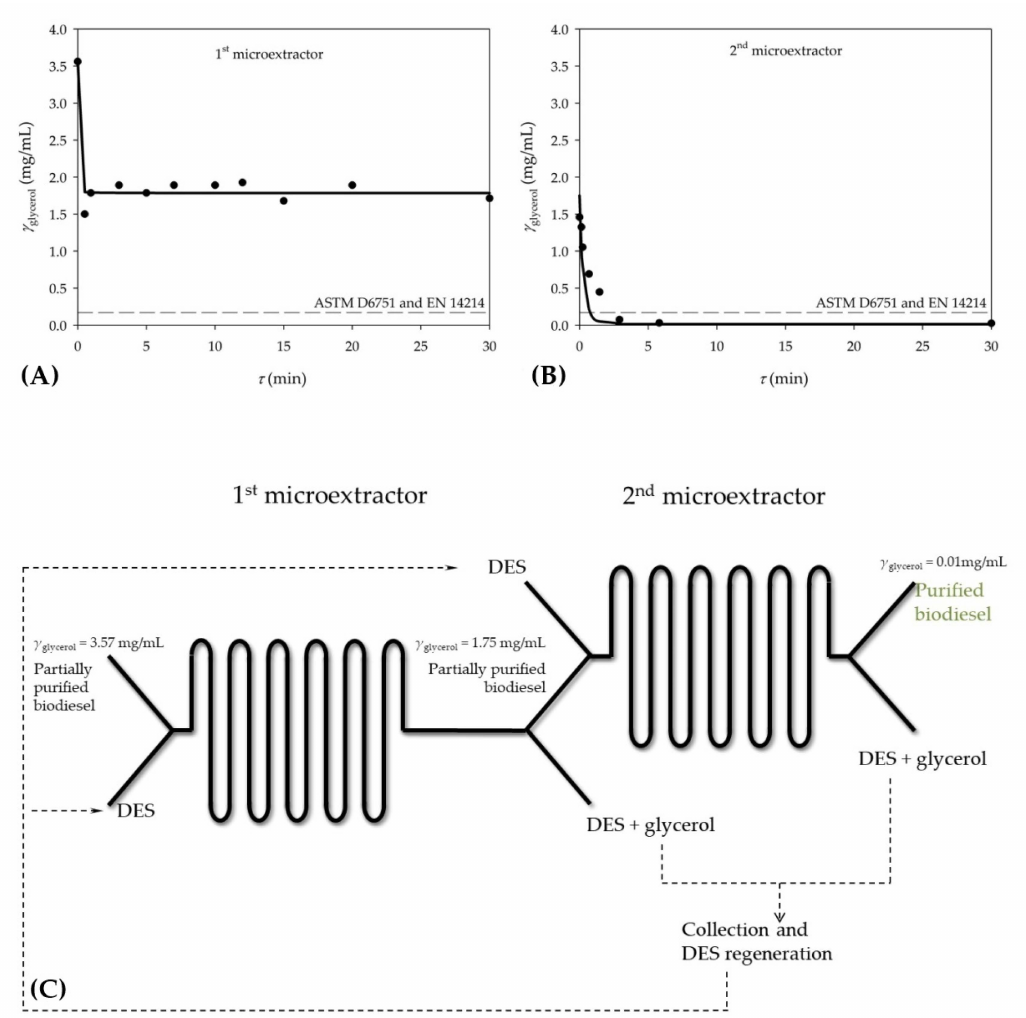
Figure 7. Influence of the residence time on the extraction of glycerol from biodiesel using DES as a solvent ( A ) glycerol concentration in 1st microextractor, ( B ) glycerol concentration in a 2nd microextractor and ( C ) proposed system composed of two microextractor connected into series for extraction of glycerol from biodiesel [ ▬ mathematical model, ● experimental results (DES